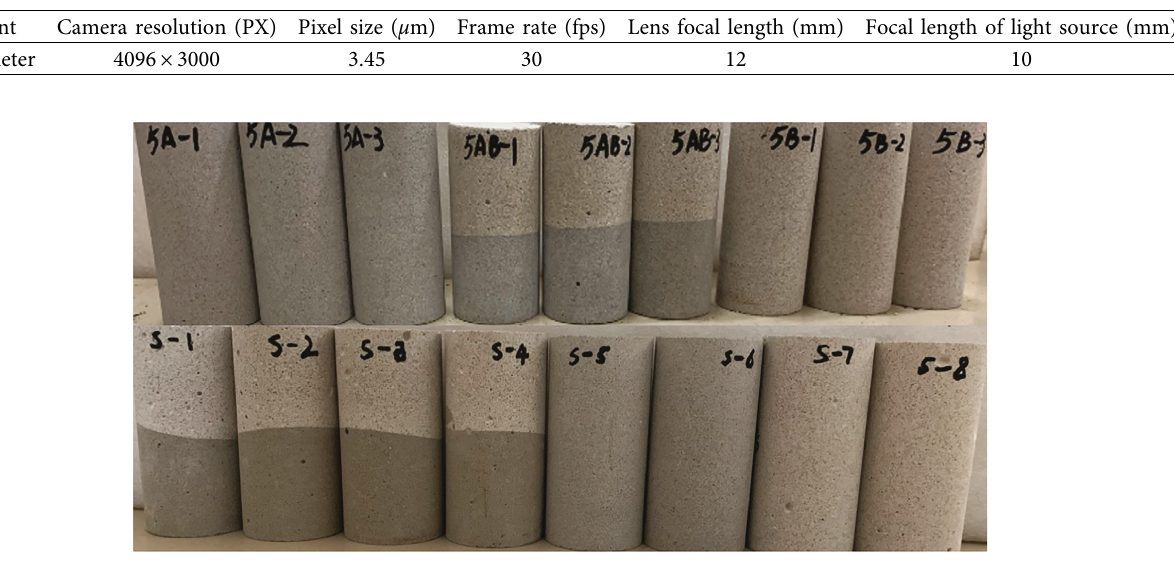
Table 3: Main parameters of DIC system.